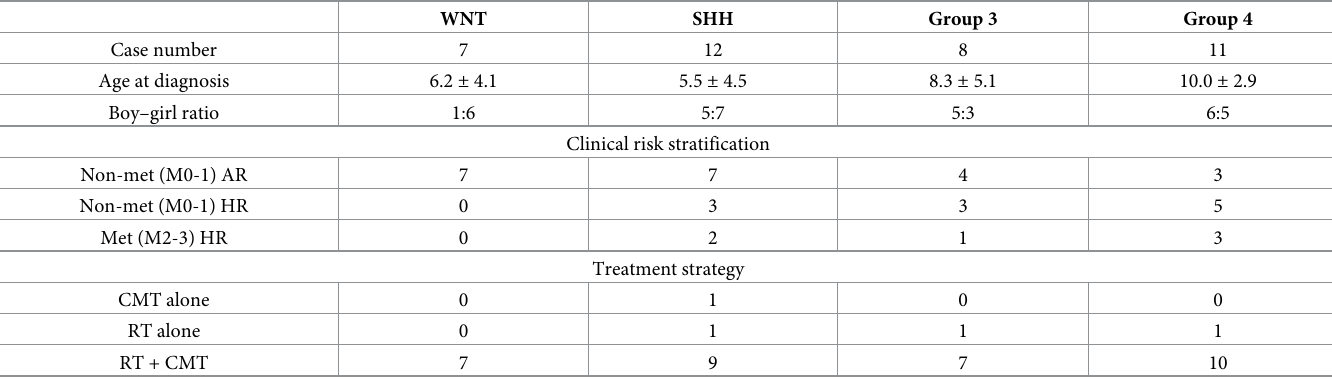
Table 1. Clinical profiles of the study